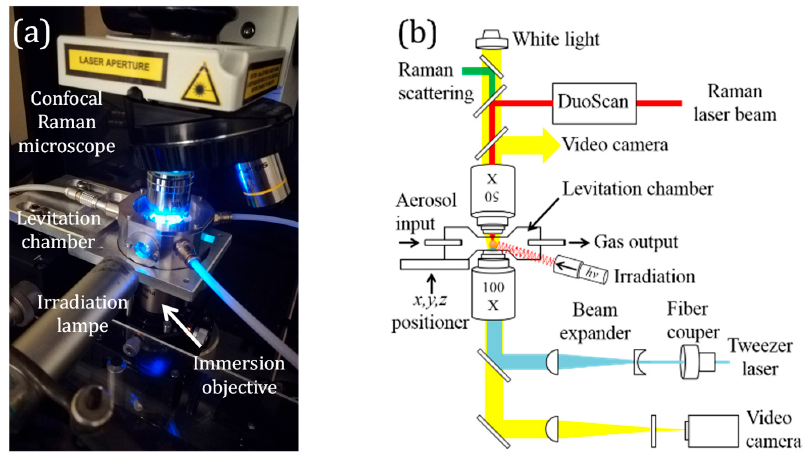
Figure 2. Experimental setup. ( a ) Photograph and ( b ) schematic diagram of the dual-objective LTRS system used in this study for the physico- and photochemical study of levitated aerosols in air.